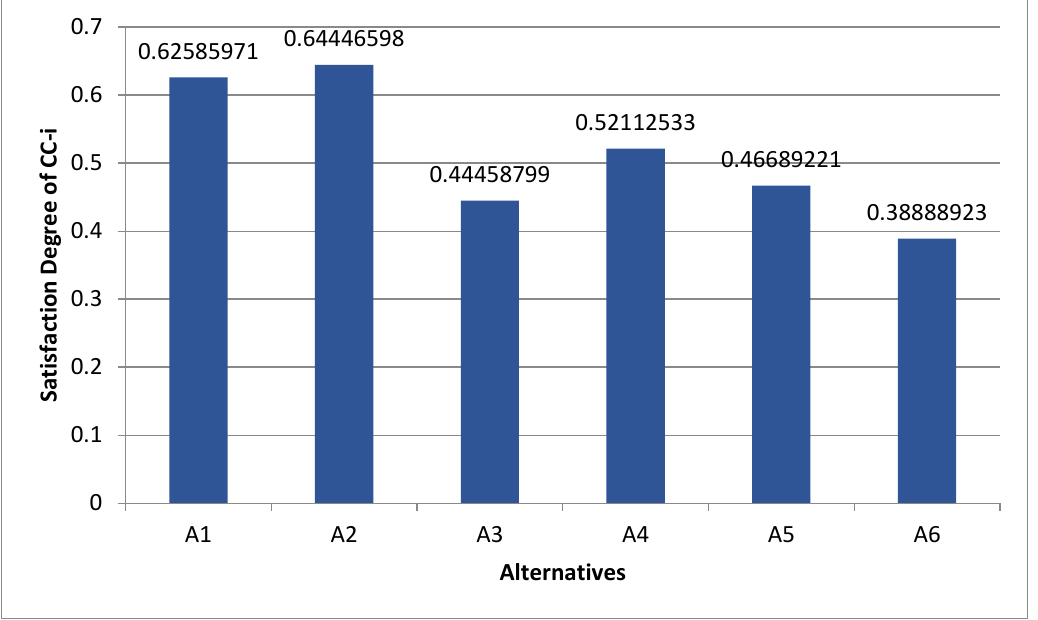
Figure 3. Satisfaction Degree of CC-i.